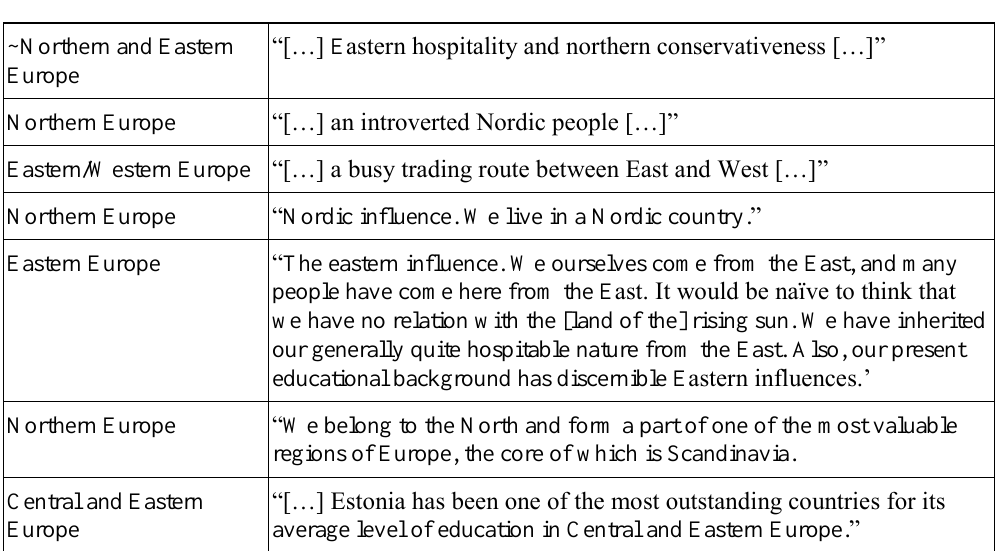
Table 3. References to Geographical Identity of